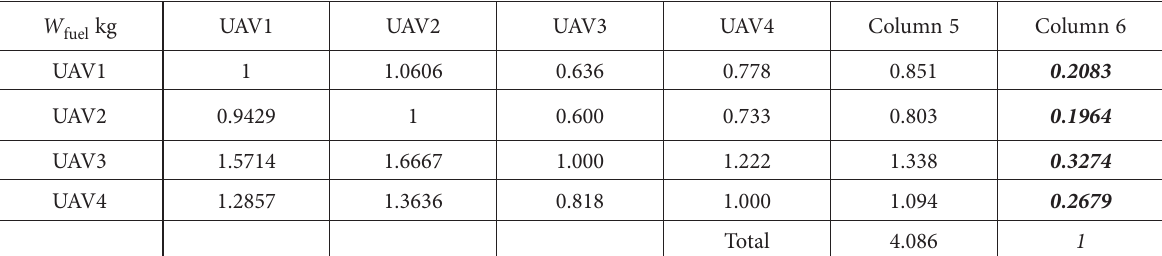
Table 12. Matrix of fuel